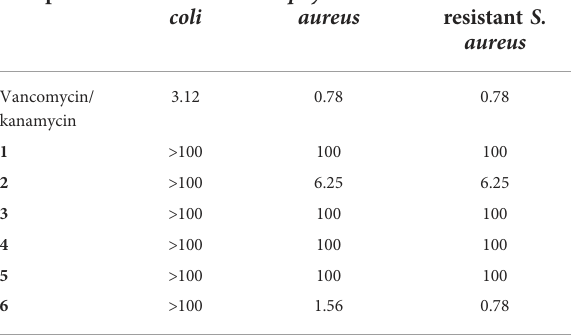
TABLE 4 Antibacterial activity of compounds 1 – 6 (minimum inhibitory concentration, m g/ml). Compounds Escherichia coli